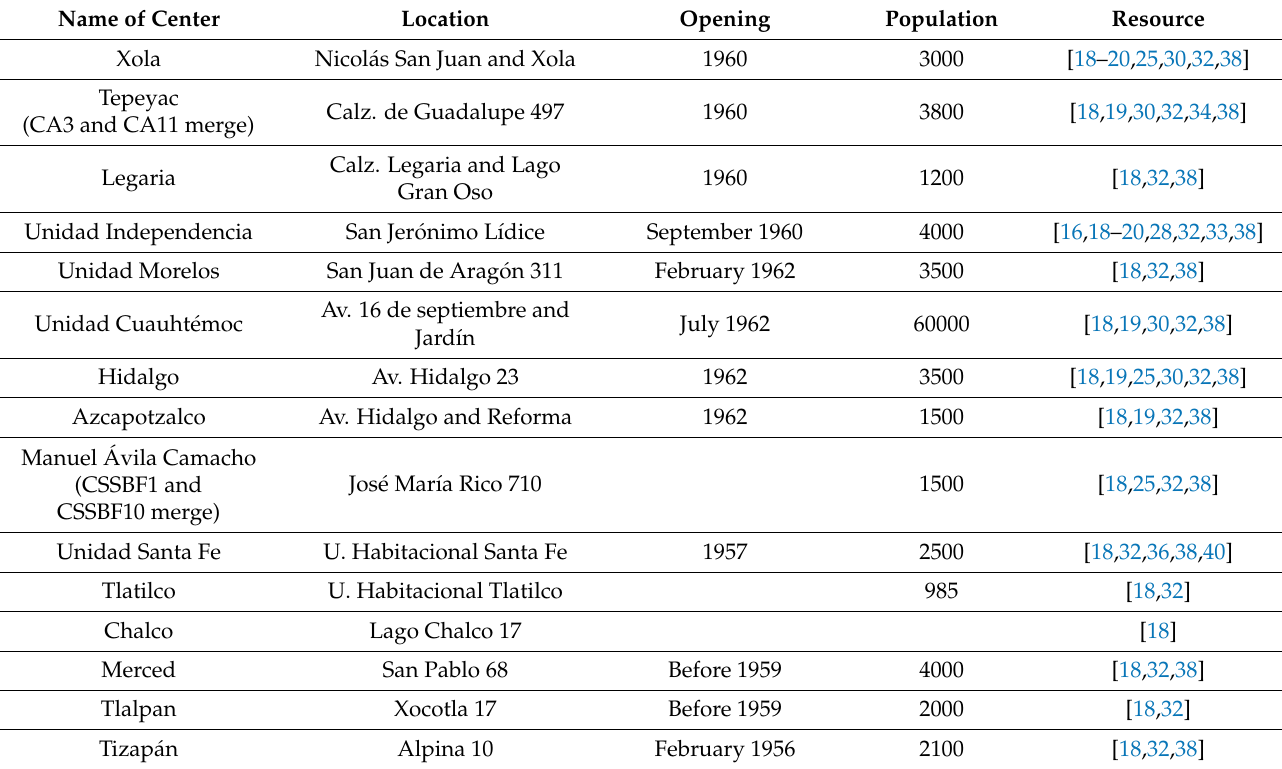
Table 3. Listing and location of the CSSBFs active in 1971 in Mexico City, according to